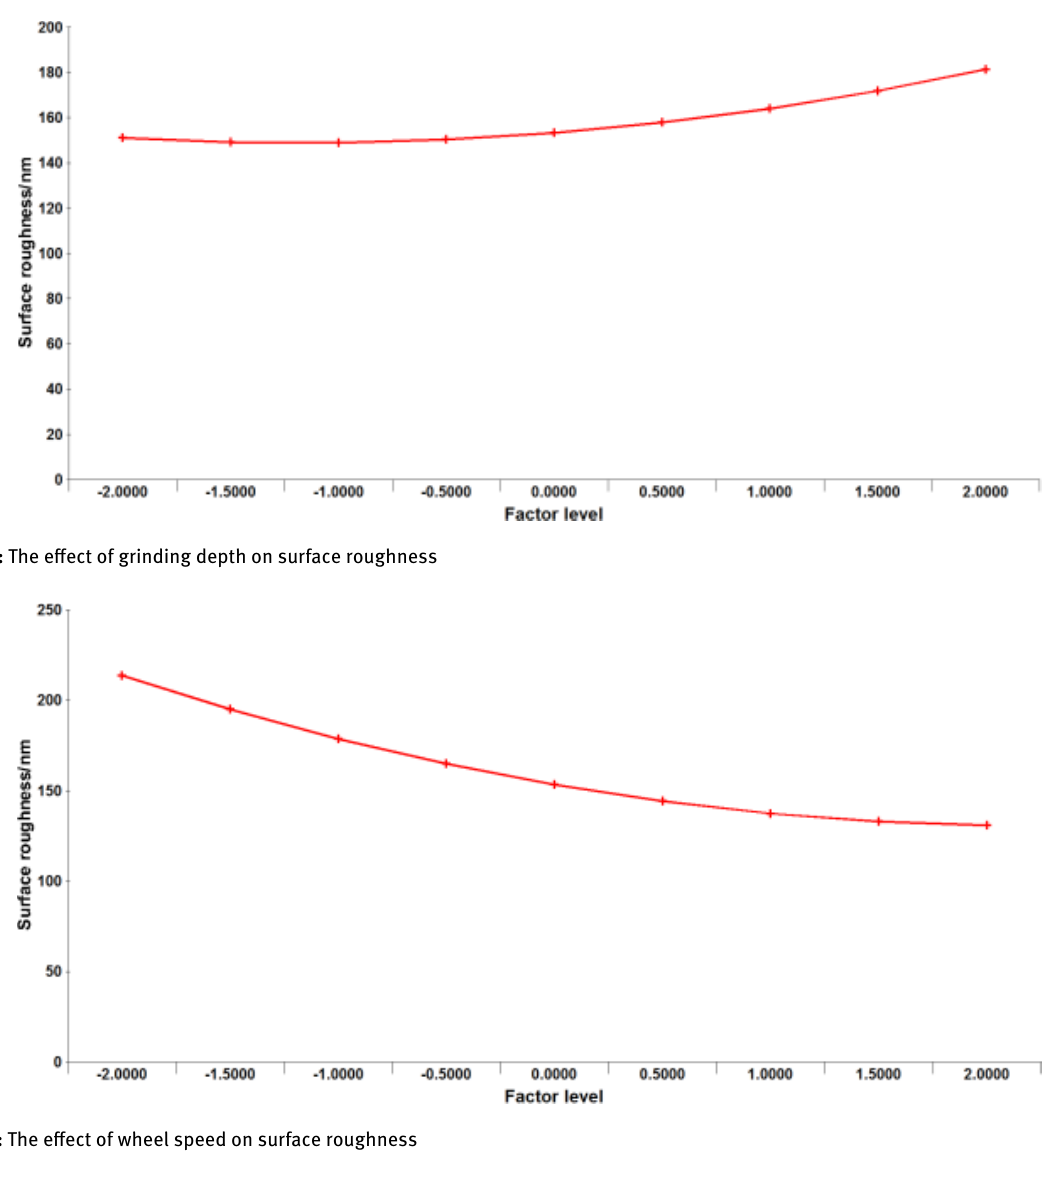
(2) Analysis of the influence of the linear speed of the grinding wheel on the surface